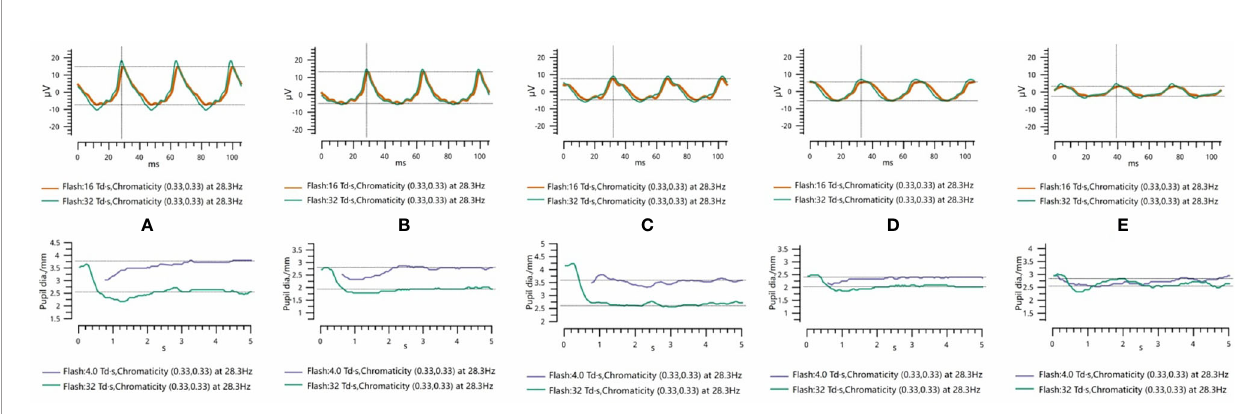
FIGURE 1 | The representative 30Hz fl icker ERG performances and pupil diameter ratios of control (A) , no DR (B) , mild NPDR (C) , moderate-severe NPDR (D) , and PDR (E) .